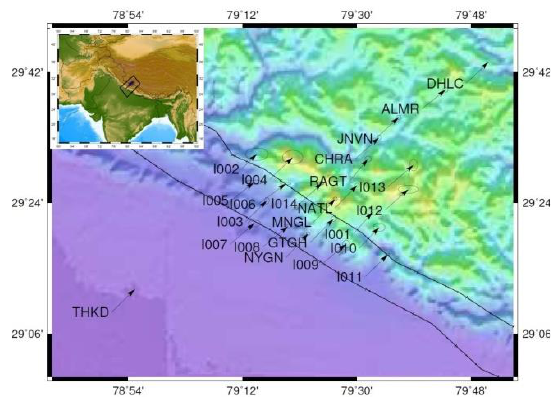
Figure 2 . Surface velocities in ITRF08 of the Garhwal- Kumaun Himalaya with major fault